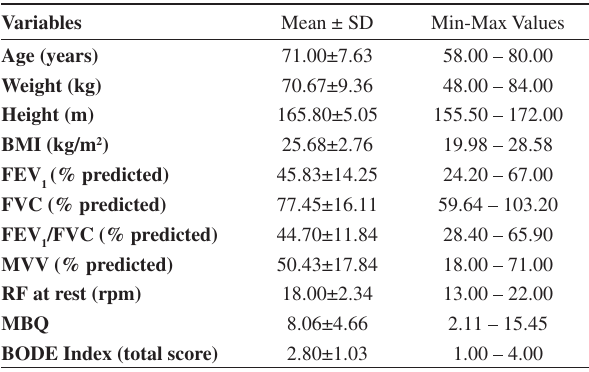
Table 1 - Anthropometric and Pulmonary Function Characteristics , Modi- fied Baecke Questionnaire, and BODE Index of the patients evaluated